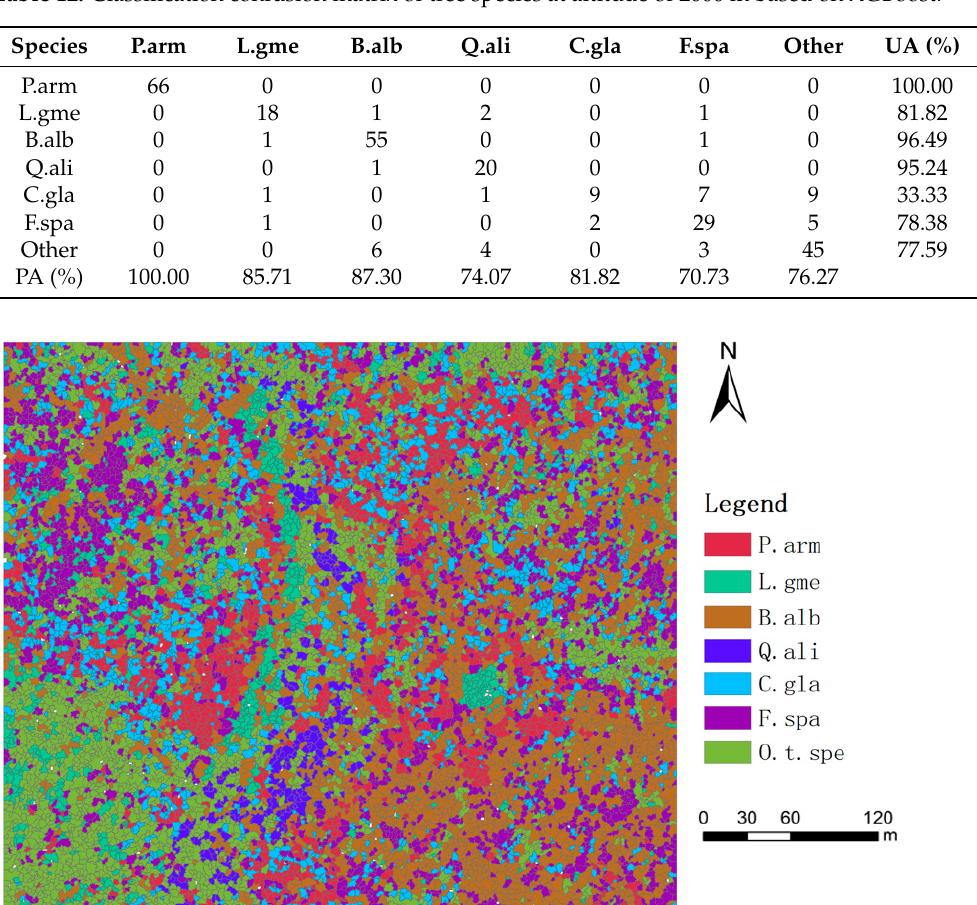
Table 12. Classification confusion matrix of tree species at altitude of 2000 m based on XGBoost.